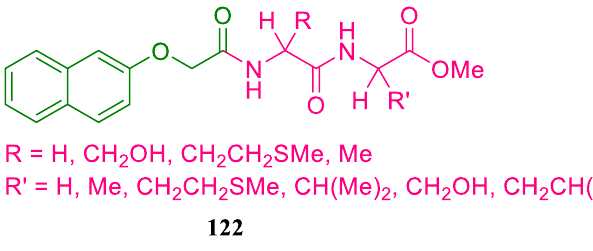
Figure 99. Peptide derivatives conjugated to naphthalene